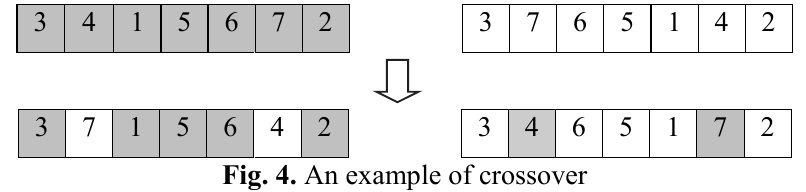
Fig. 4. An example of crossover